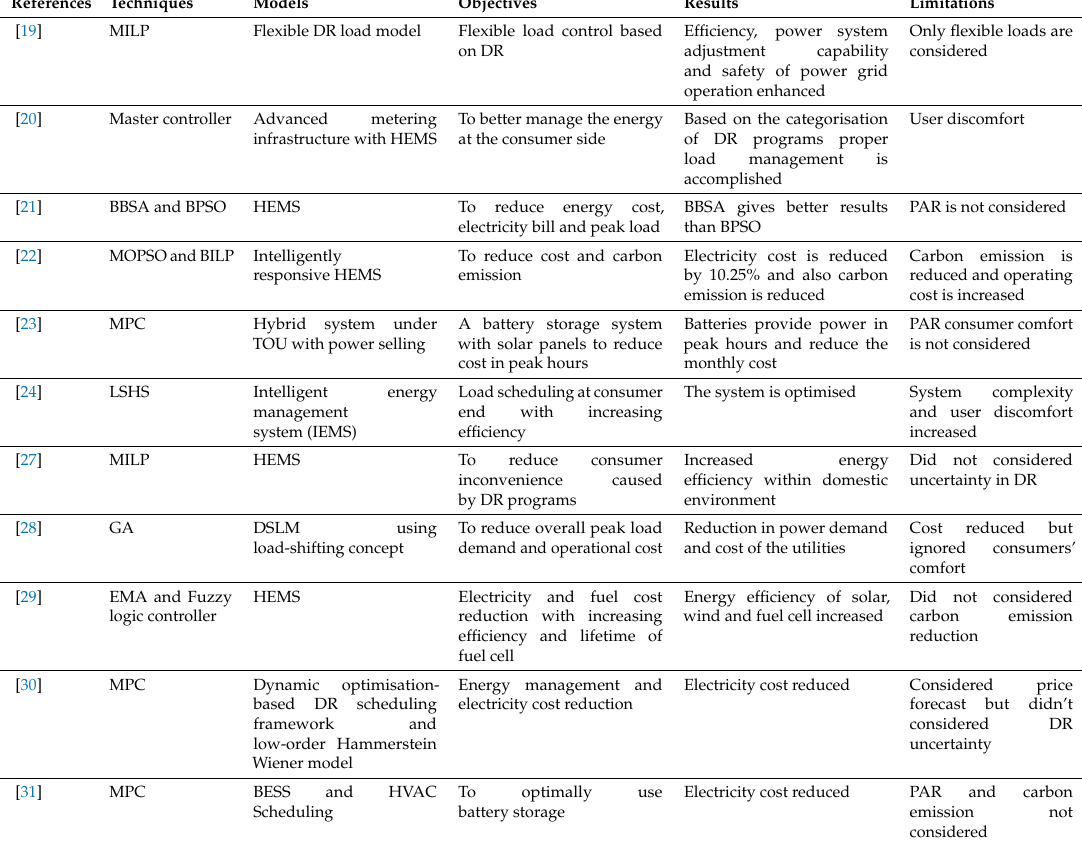
Table 1. Summary of related work in terms of techniques, model, objectives, results and